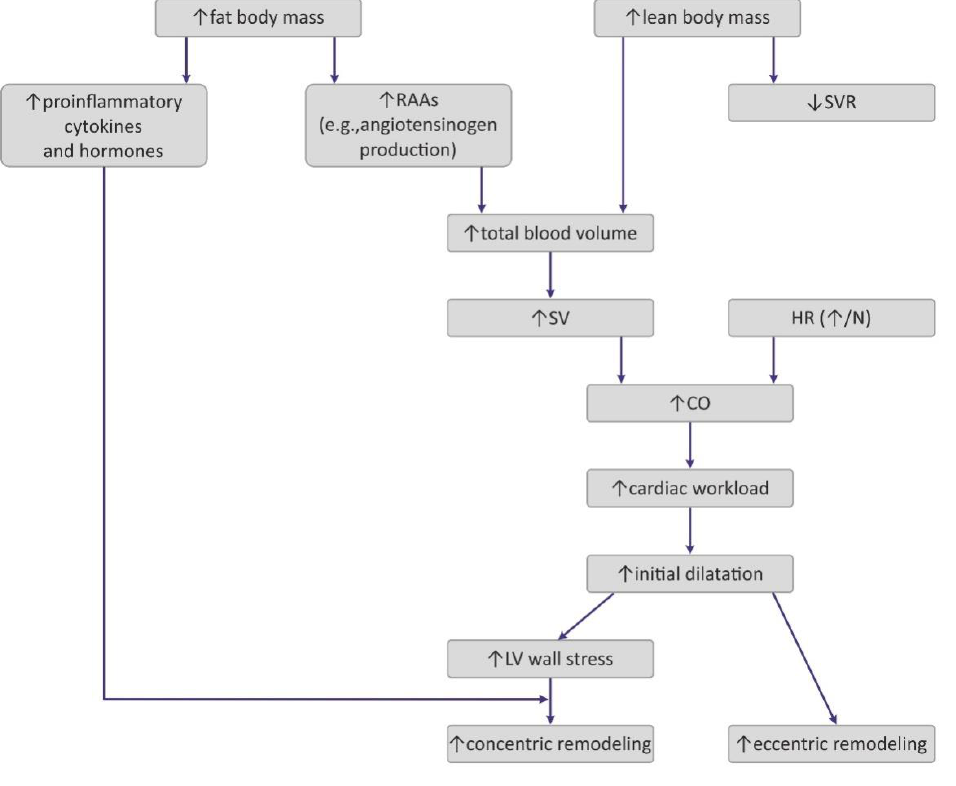
Figure 1. Pathogenesis of hemodynamic alterations in the course of obesity. RAAs—renin– angiotensin–aldosterone system; SVR—systemic vascular resistance; SV—stroke volume; HR—heart rate; CO—cardiac output; LV—left ventricle.